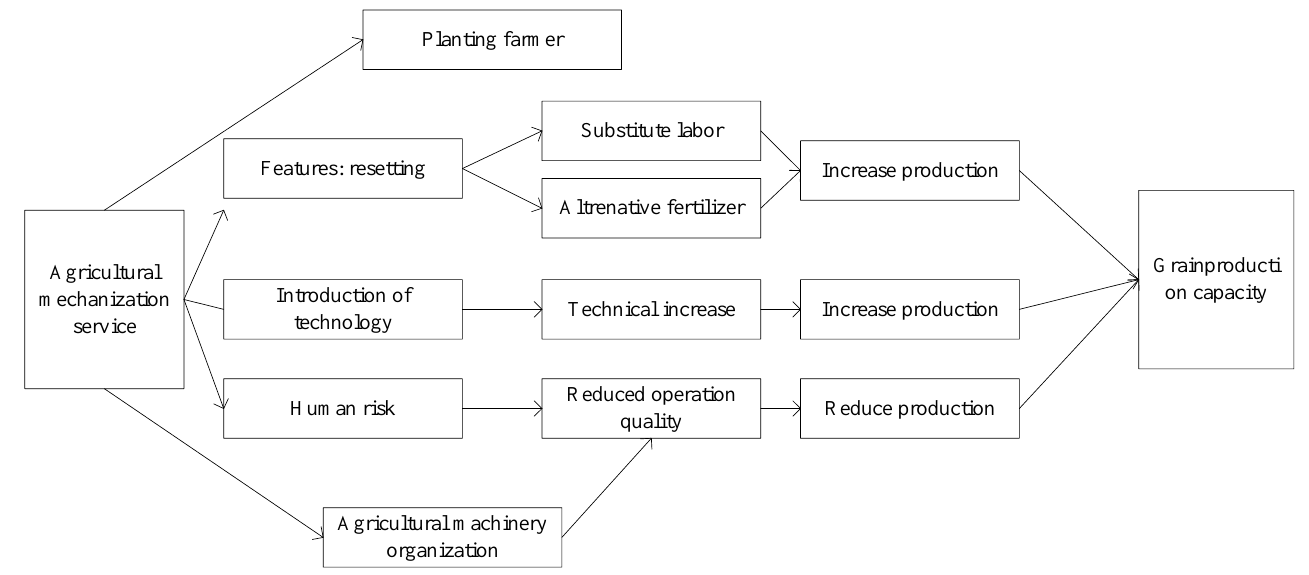
Figure 2. Impact mechanism of agricultural mechanization service on grain production efficiency. In Formula (13), people represents the sample group aged six years and above, prs represents the number of groups with primary school education, jms represents the number of groups with junior high school education, sms represents the number of groups with high school education, and jc represents the number of groups withcollege education and above, respectively. The rice stand-alone model isshown in Formula (14).